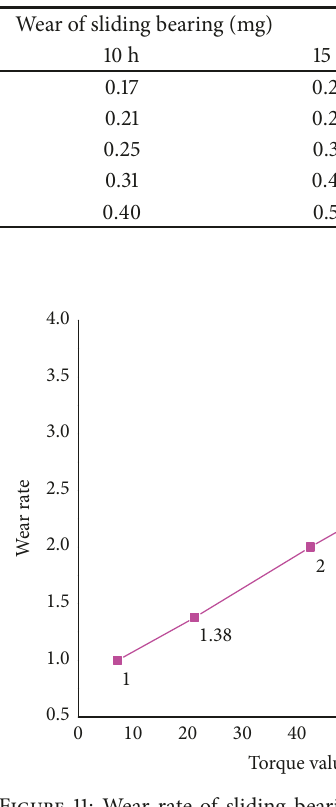
Table 7: Wear of sliding bearing II under constant torque excitation.